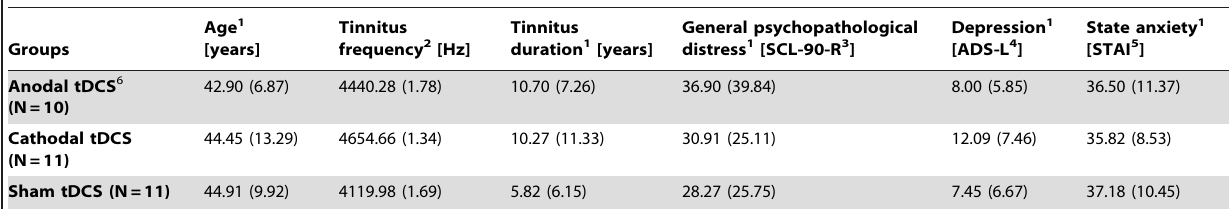
Table 1. Patient characteristics.